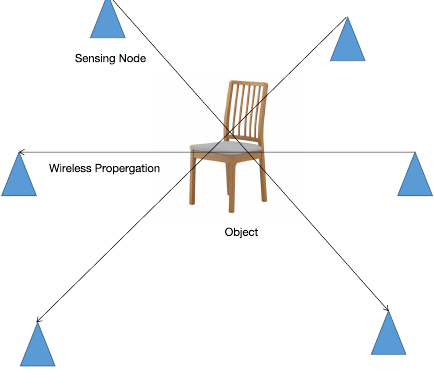
Figure 1. An illustration of the RF tomographic imaging